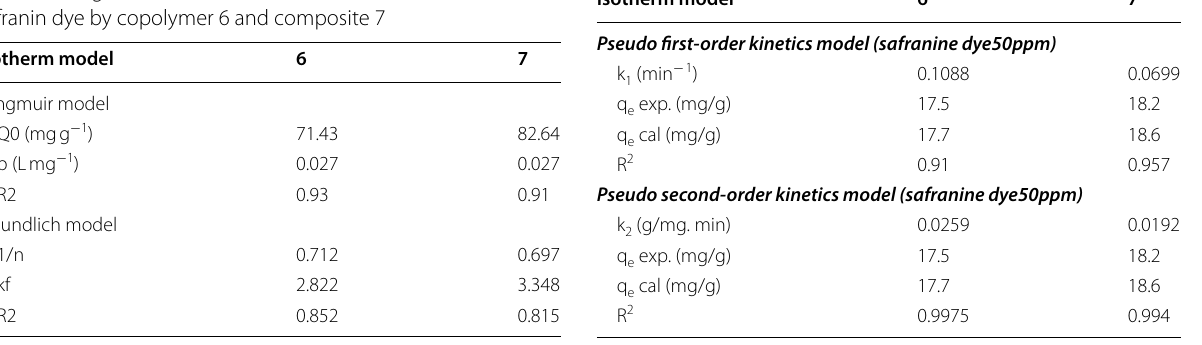
Table 2 Different kinetic model parameters for the removal of safranin dye by copolymer 6 and composite 7 Isotherm